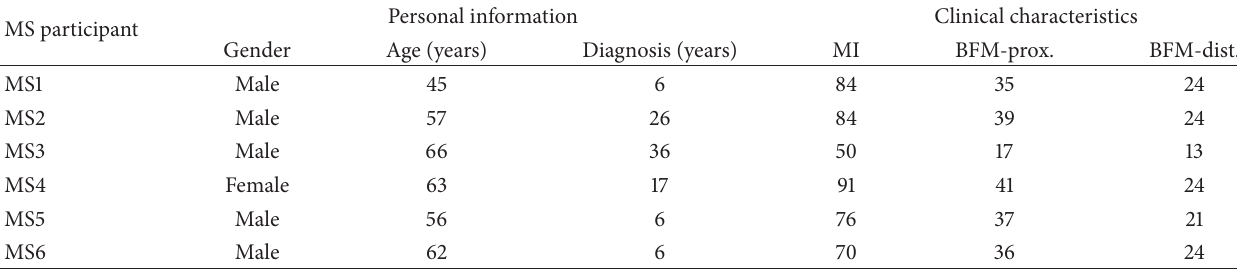
Table 1: Personal and clinical information of MS participants in the experiment.